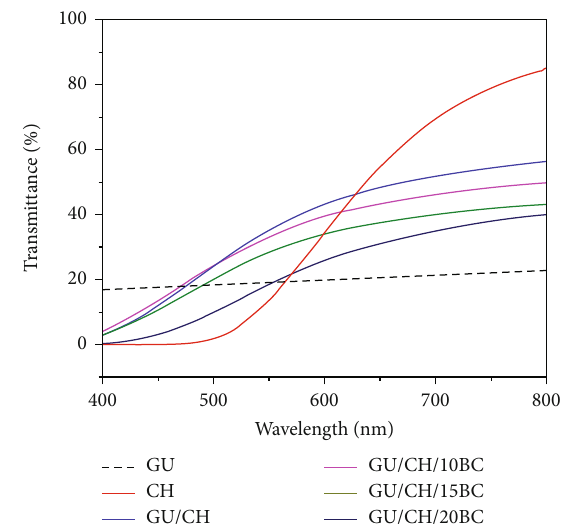
Figure 4: The transmittance of all